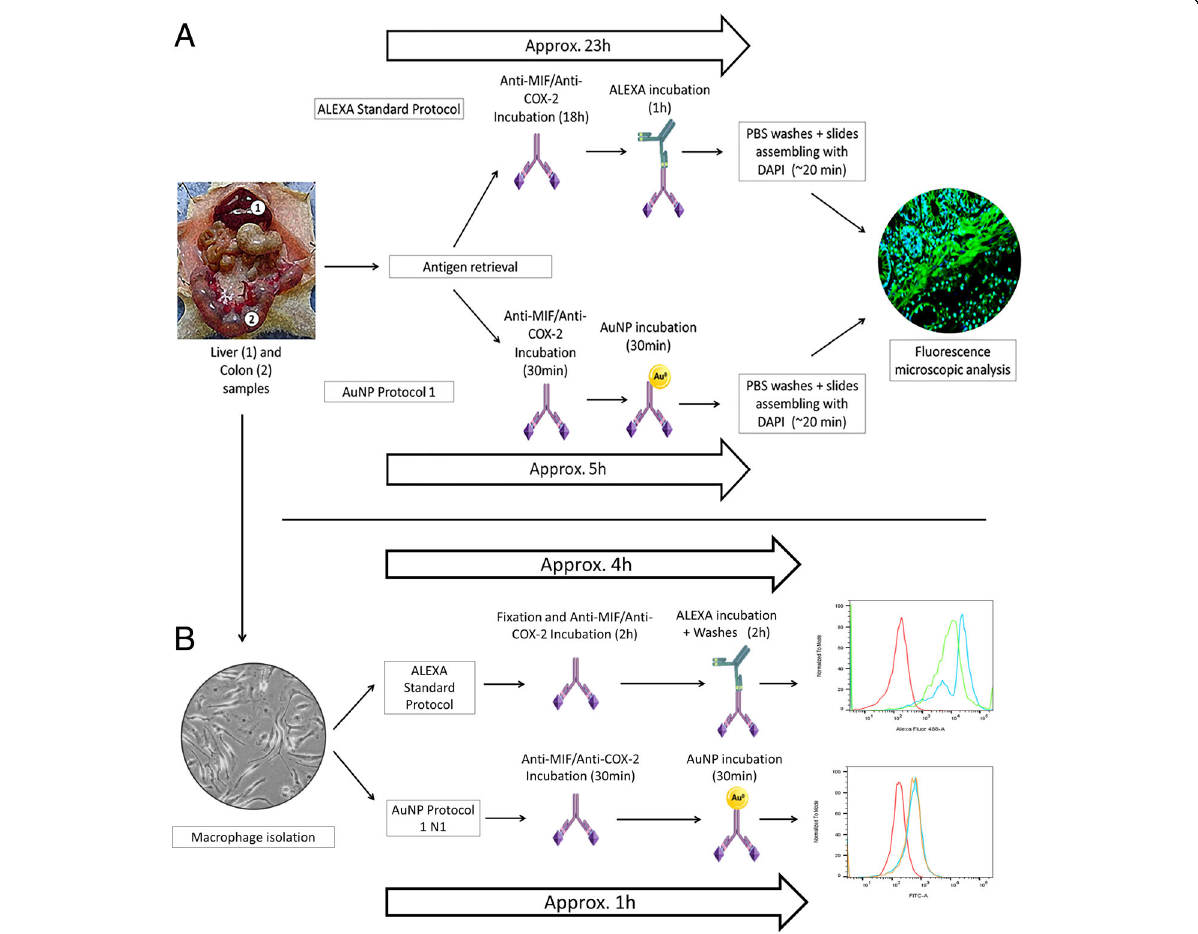
Fig. 7 Comparative schemes illustrating the immunofluorescence ( a ) and flow cytometry protocols used in this study ( b ). In immunofluorescence, AuNPs may be applied in 30-min incubation protocols as fluorescence-enhancing agents, providing faster results with comparable fluorescence levels to the traditional ALEXA protocol, which makes NP1 a suitable protocol for cancer diagnose. Time was counted from the antigen retrieval to the end of the second incubation. In flow cytometry, although the ALEXA marking was higher than that of the AuNPs, the N1 protocol with AuNPs allowed a greater saving of reagents as well as reduced the time required for the technique from 4 to 1